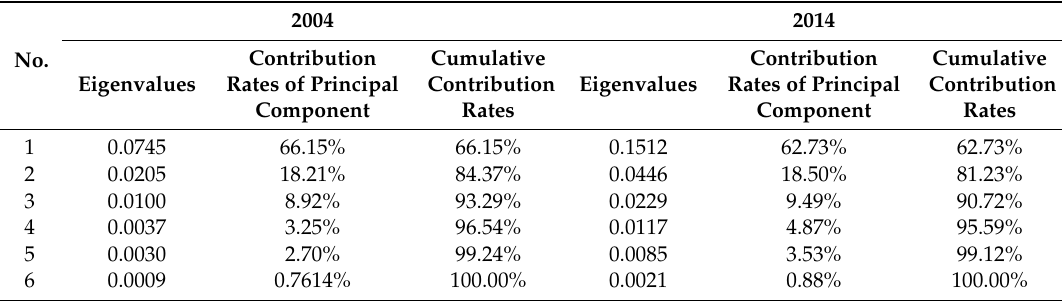
Table 3. Correspondence analysis results from 2004 and 2014 (eigenvalues, contribution rates of principal component, and cumulative contribution rates) for each of six